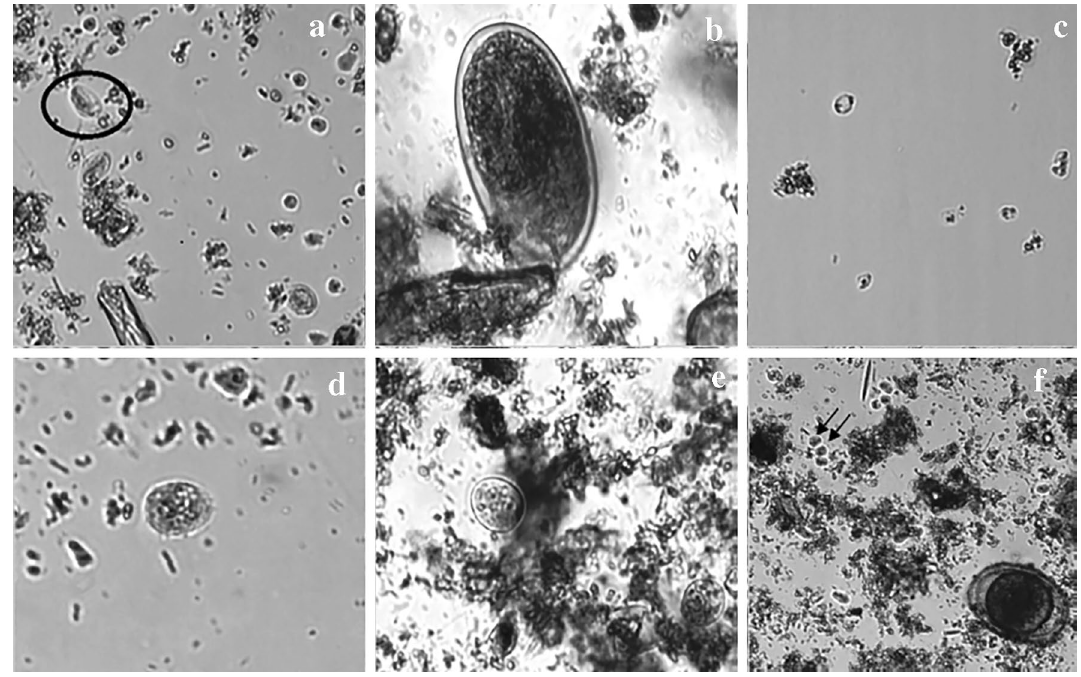
Figure 2. Images from SediMAX2 software. A. Giardia lamblia cysts (circled). B. Hookworm egg. C. Blastocystis hominis vacuolar stage. D. Entamoeba hystolitica/dispar cyst. E. Entamoeba coli cysts. F. Double infection of Endolimax nana cysts (arrows) and Ascaris lumbricoides